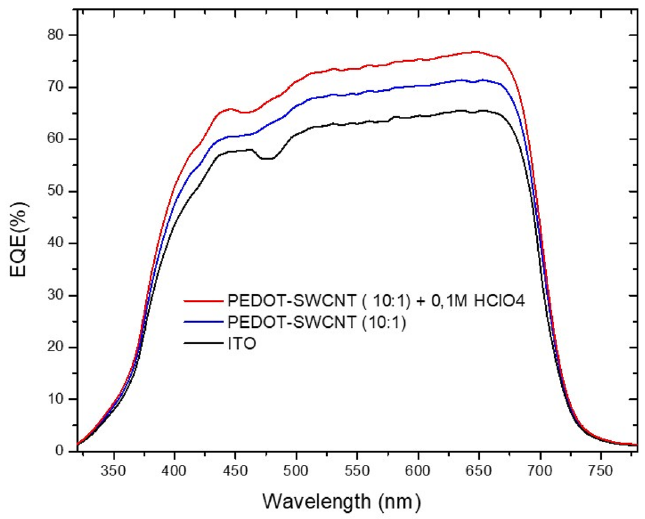
Figure 11. EQE spectra for the three devices based on different types of ITO cathodes, blends of PEDOT- SWNTs and PEDOT- SWNTs + (0.1 M) HClO 4